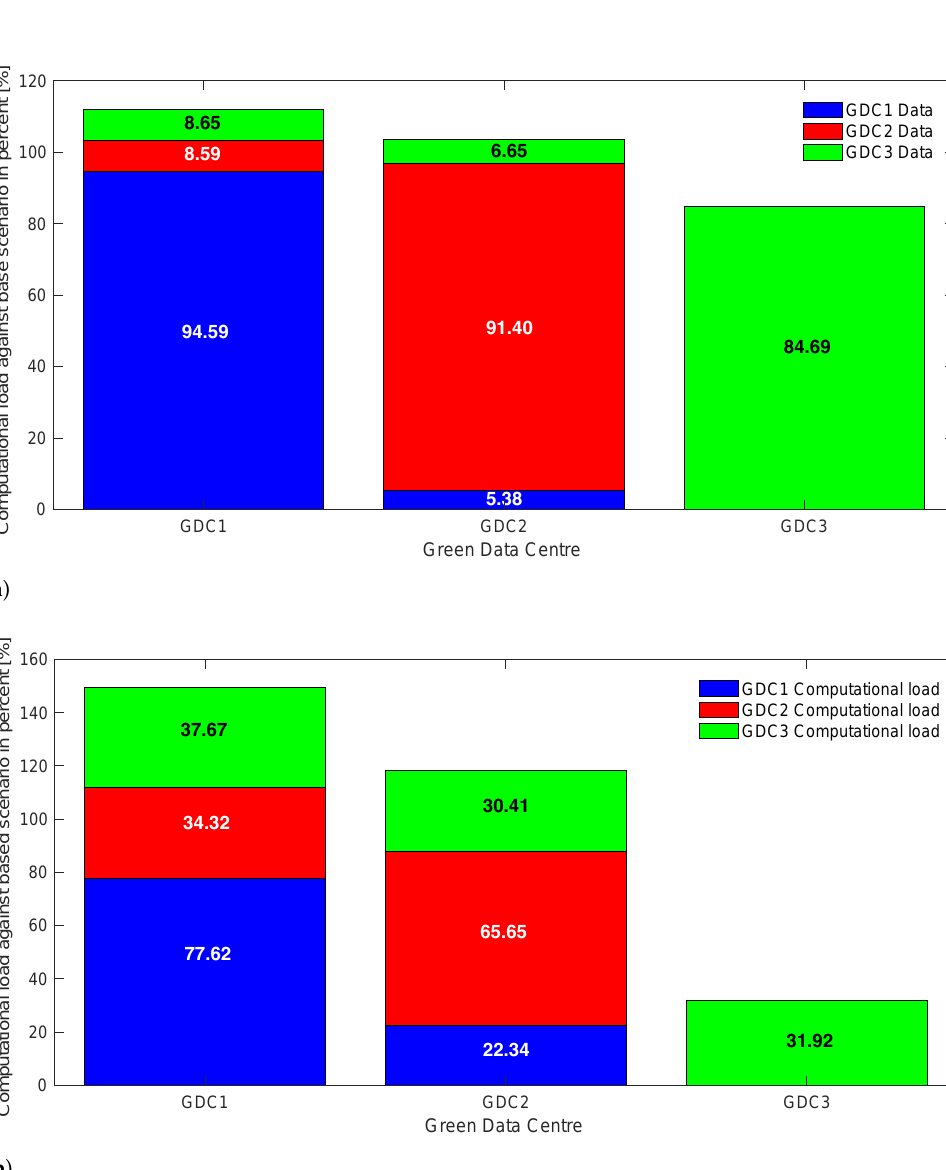
Figure 7. Total annual computational load of the three green data centres against the base scenario for ( a ) Scenario 1—limited data transfer, and ( b ) Scenario 2—unlimited data transfer, between the GDCs.